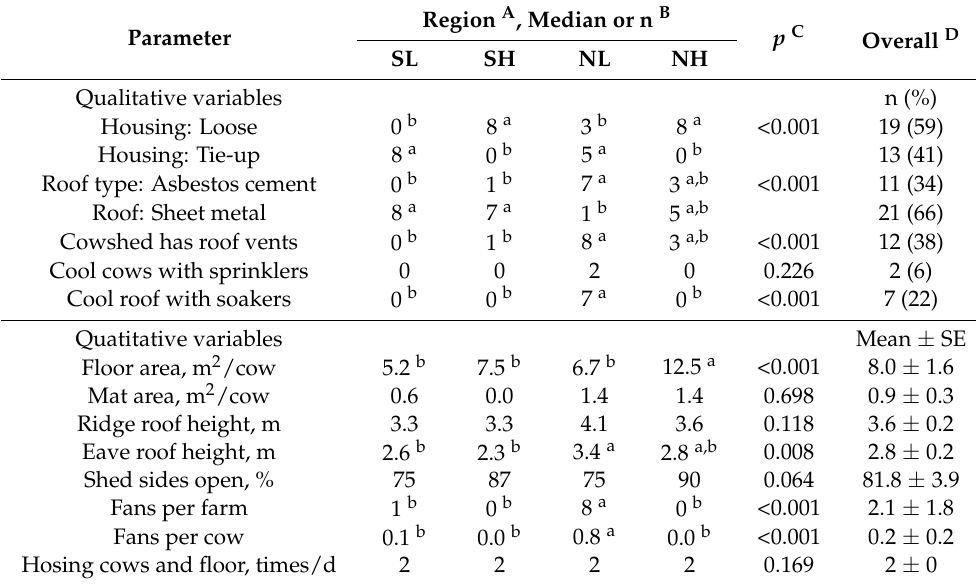
Table 4. Housing management parameters of smallholder dairy farms in four dairy regions. Region A , Median or n Parameter